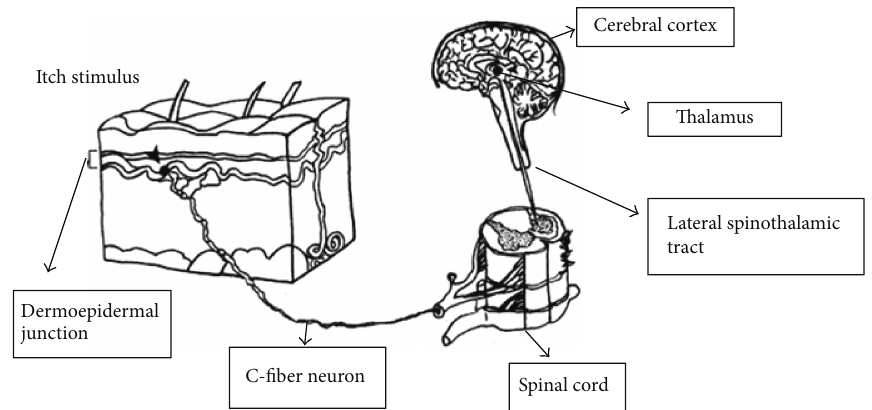
Figure 1: Neurological pathways of